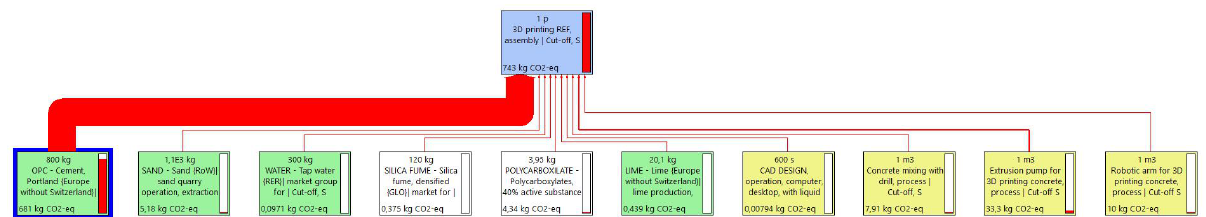
Figure A1. SimaPro GWP network for p-CTR mix processing.